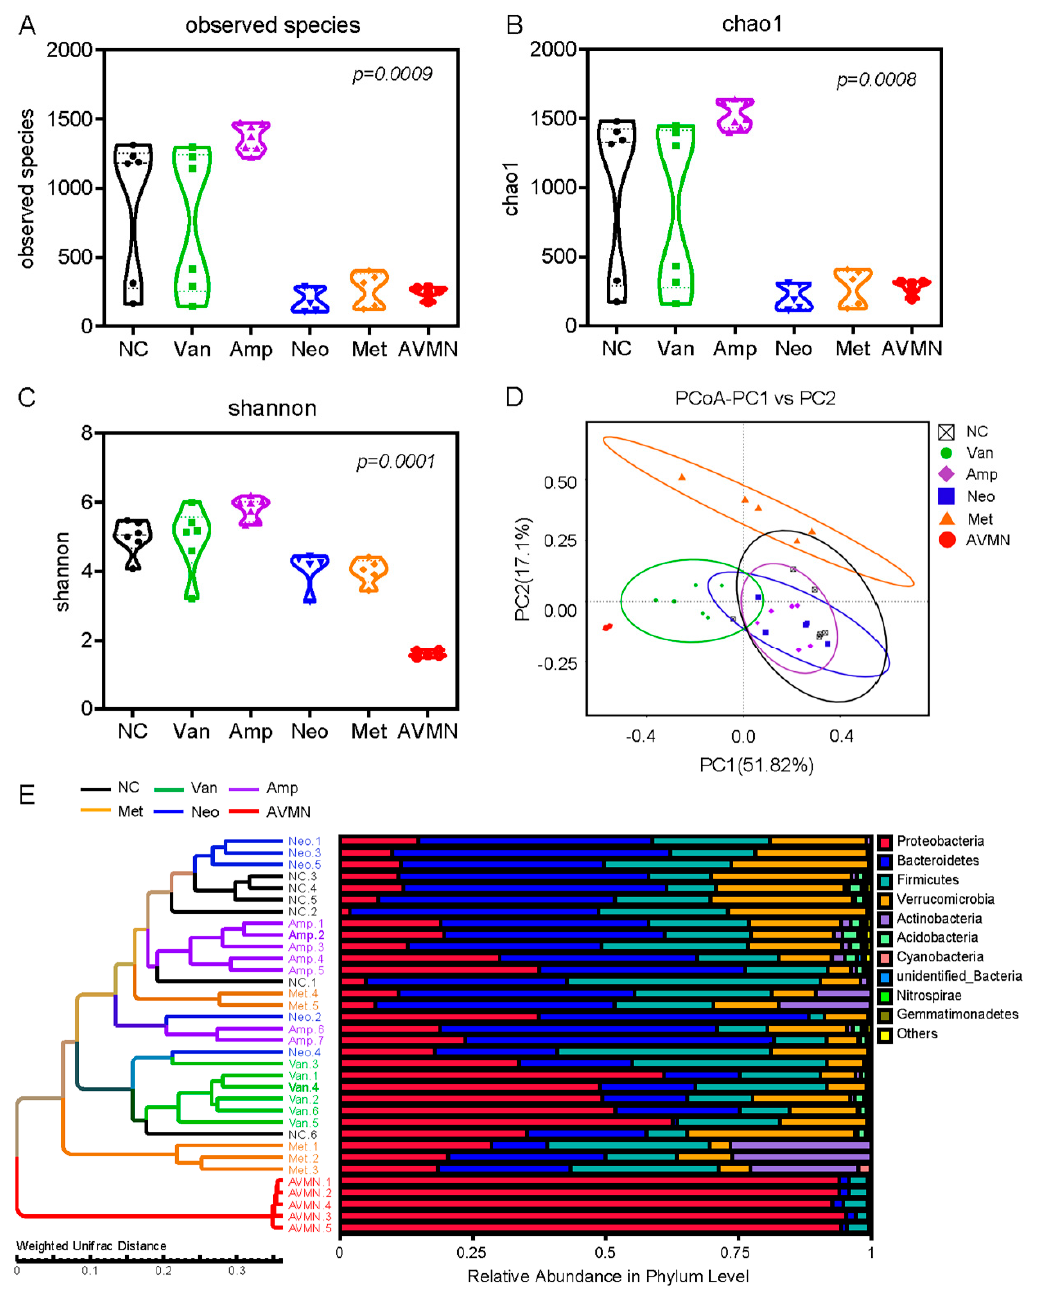
Figure 2. Antibiotic treatment reshapes gut microbiota in mice. ( A – C ) Comparison of alpha-diversity of gut microbiota among all groups of mice using observed—species ( A ), the Chao1 index (richness) ( B ) and Shannon’s index (diversity) ( C ). Analyses were performed using Kruskal—Wallis test. In the box plots, upper and lower hinges correspond to the first and third quartiles; the center line represents the median; and whiskers indicate the highest and lowest values. ( D ) Principal coordinate analysis (PCoA) using the Bray—Curtis dissimilarity metric of beta-diversity among samples of the six groups of mice analyzed. Each dot represents an individual mouse. PCo1 and PCo2 represent the percentage of variance explained by each coordinate. ( E ) UPGMA tree on the OUT level representing the beta-diversity analysis of all groups analyzed using the weighted—UniFrad and the community map of dominant phyla in each group. NC, n = 6; Van, n = 6; Amp, n = 7; Neo, n = 5; Met, n = 5; AVMN, n = 5.